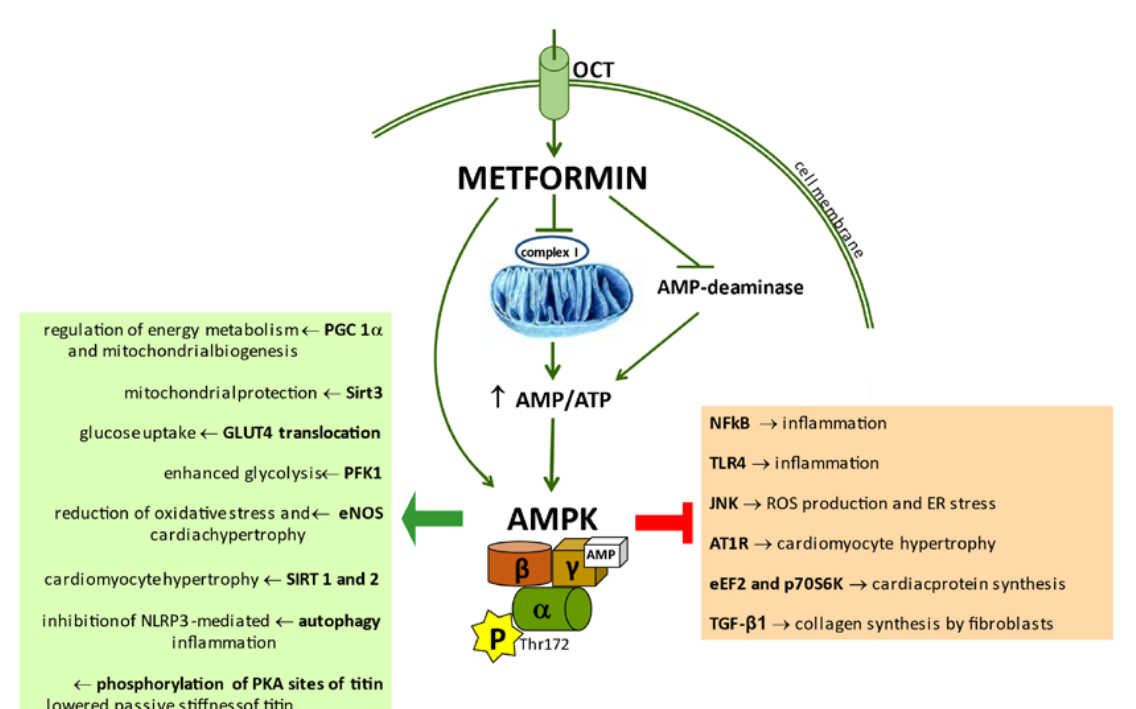
Figure 1. Activation of AMPK by metformin and its principal downstream pathways involved in HF physiopathology. AMPK: AMP-dependent kinase; AT1R: AngII type 1 receptor; eNOS: endothelial nitric oxide synthase; eEF2: eukariotic elongation factor-2 kinase; GLUT4: glucose transporter protein type-4; JNK: c-Jun N-terminal kinase; NF-kB: nuclear factor-kB; OCT: organic cation transporter; p70S6K: protein kinase 70S6; PFK1: phosphofructokinase 1; PGC1 α : peroxisome proliferator-activated receptor-g coactivator-1 α ; PKA: protein kinase A; SIRT1-2-3: deacetylase Sirtuin 1-2-3; TGF- β : transforming growth factor- β ; TLR4: Toll-like receptor 4.